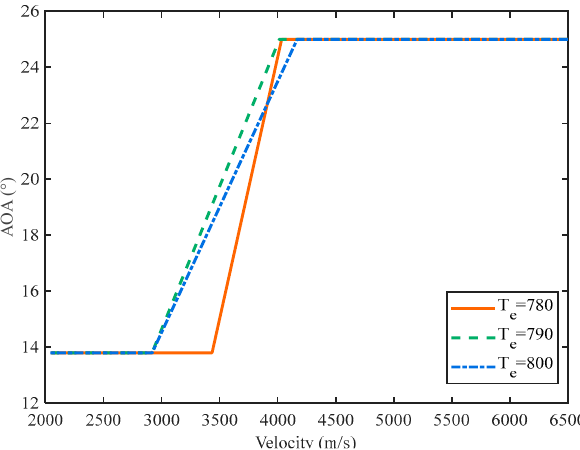
Figure 6. Velocity histories of the AOA.